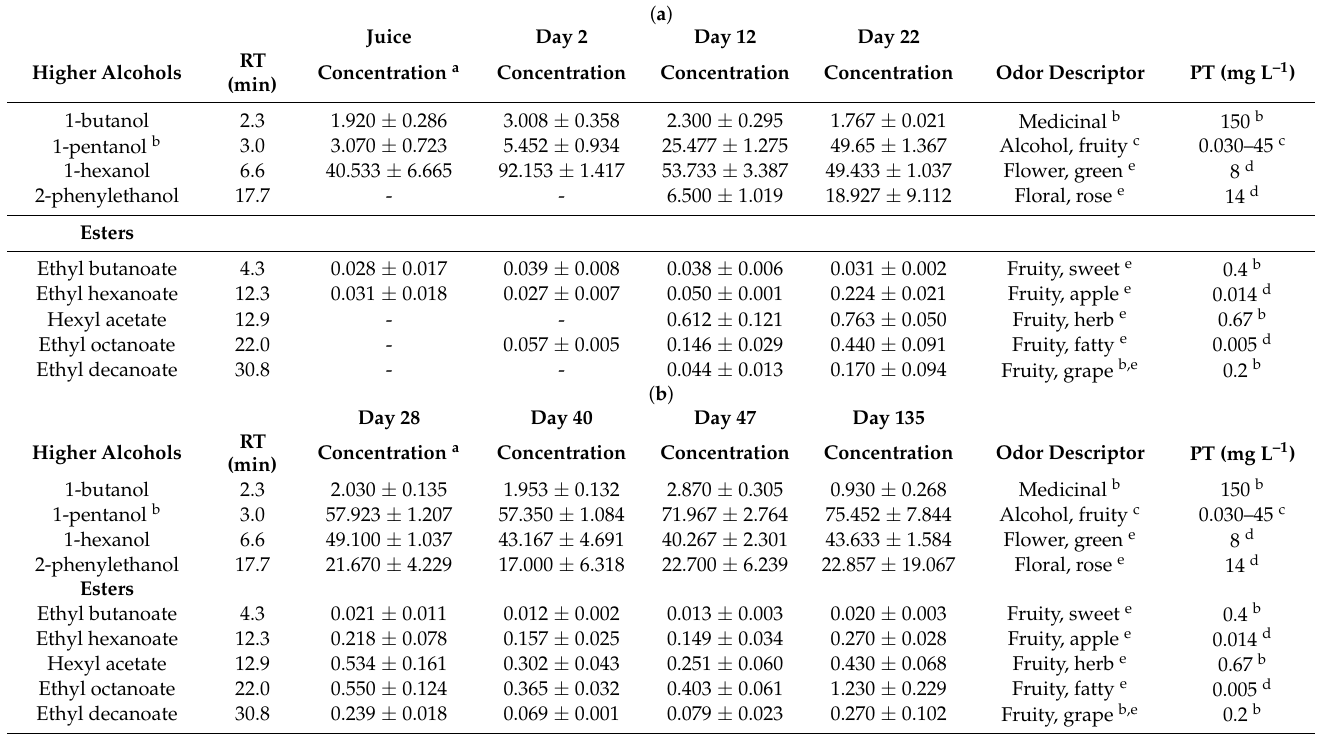
Table 1. ( a ) Representative higher alcohol and ester concentrations (mg L –1 ) from pre-inoculation through racking. ( b ) Representative higher alcohol and ester concentrations (mg L –1 ) from racking to the end of